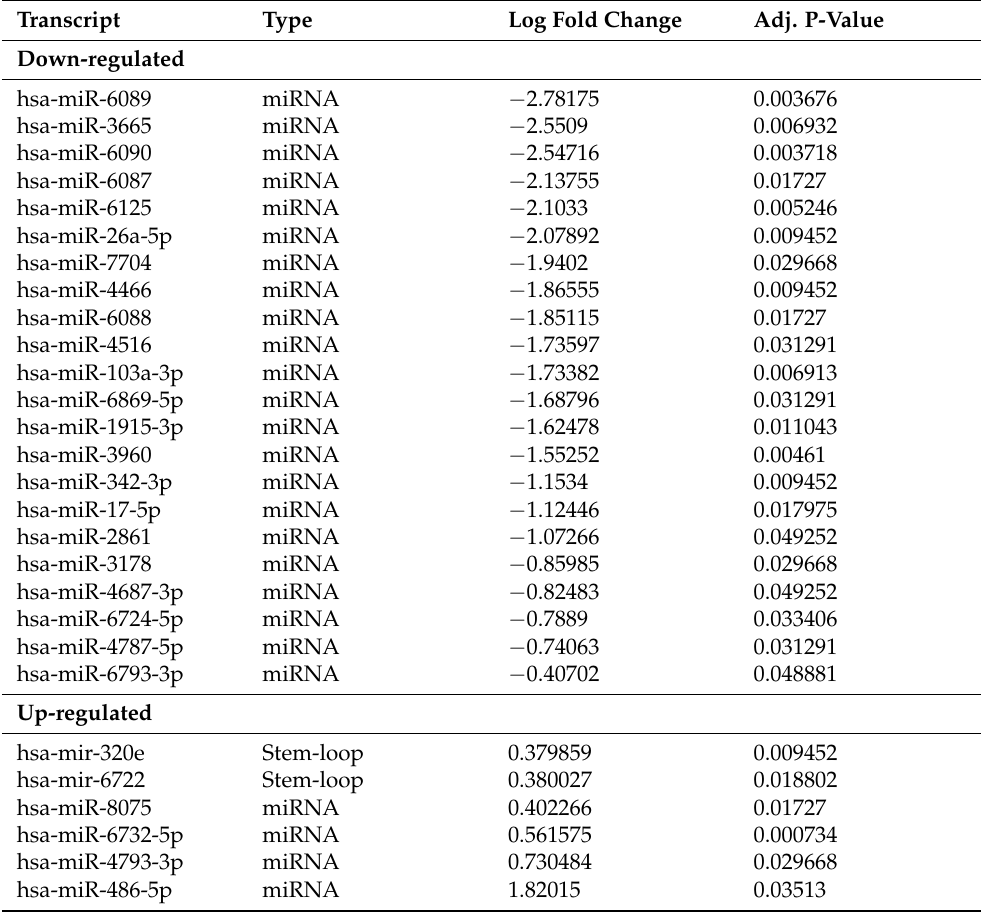
Table 1. List of significantly altered miRs obtained from microarray analysis of PAH EVs ( n = 10) when compared to their HC counterparts ( n =